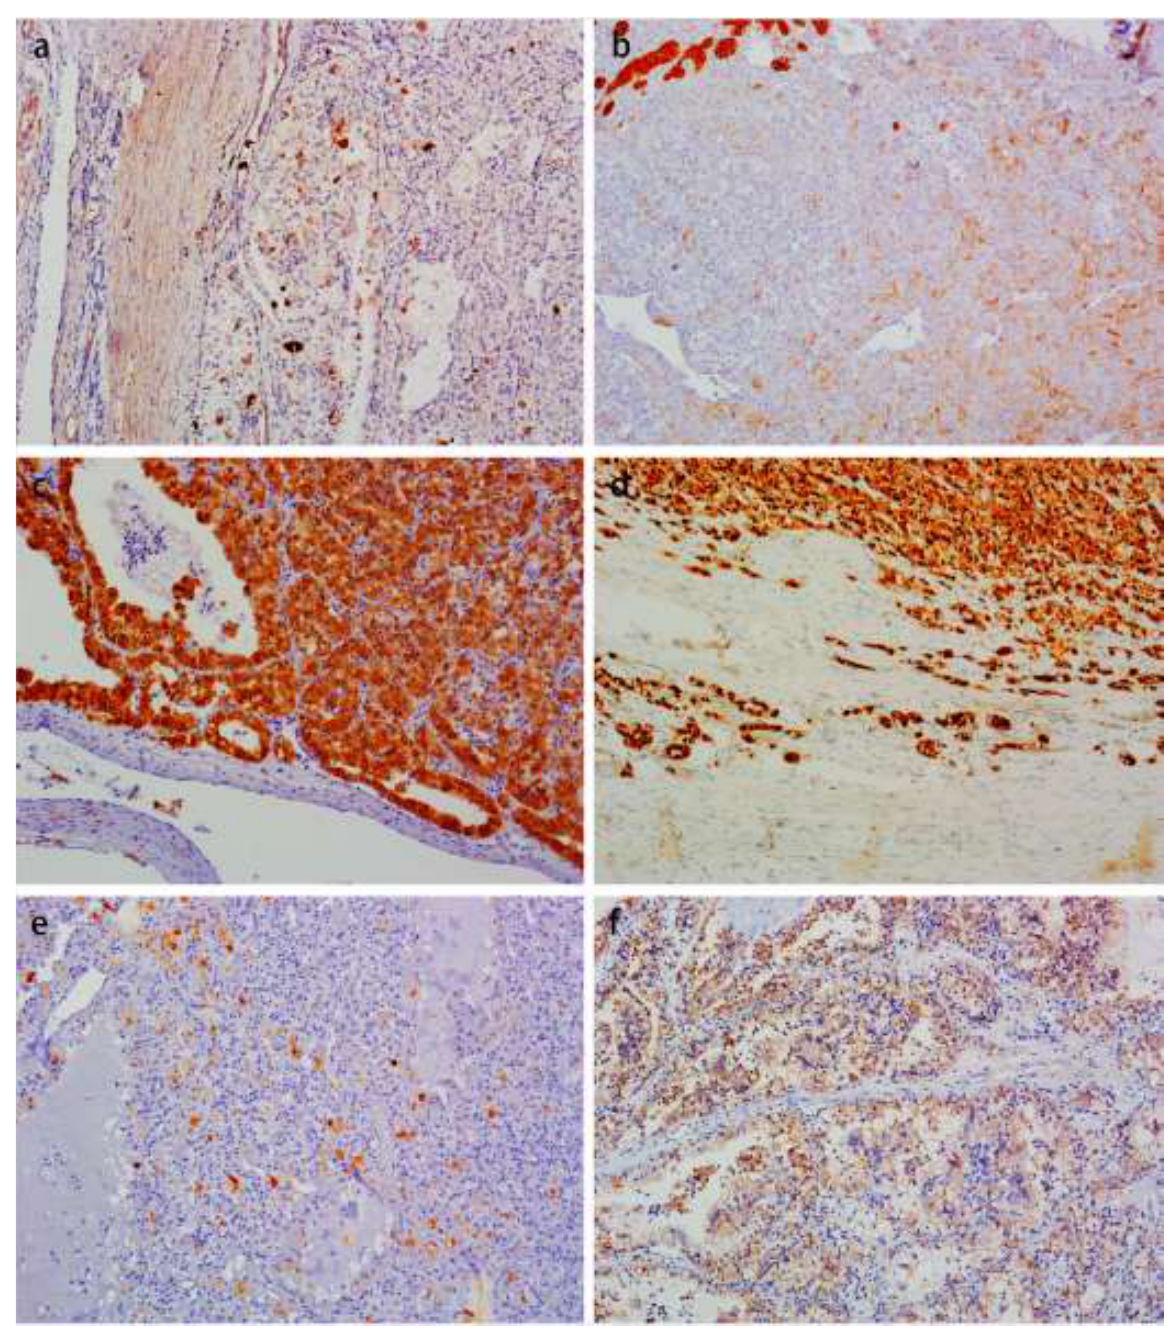
Figure 4. Immunohistochemistry profile of the TFEB rearranged RCC. These tumors were CK20 ( a ) and CK8/18 ( b ) weakly positive. All cases exhibited moderate to strong positive Melan-A ( c ), vi- mentin, TFEB ( d ). Another melanocytic marker, HMB45 ( e ), was weak–medium positively expressed. PD-L1 ( f ) was moderately to strongly positive membranous staining in all